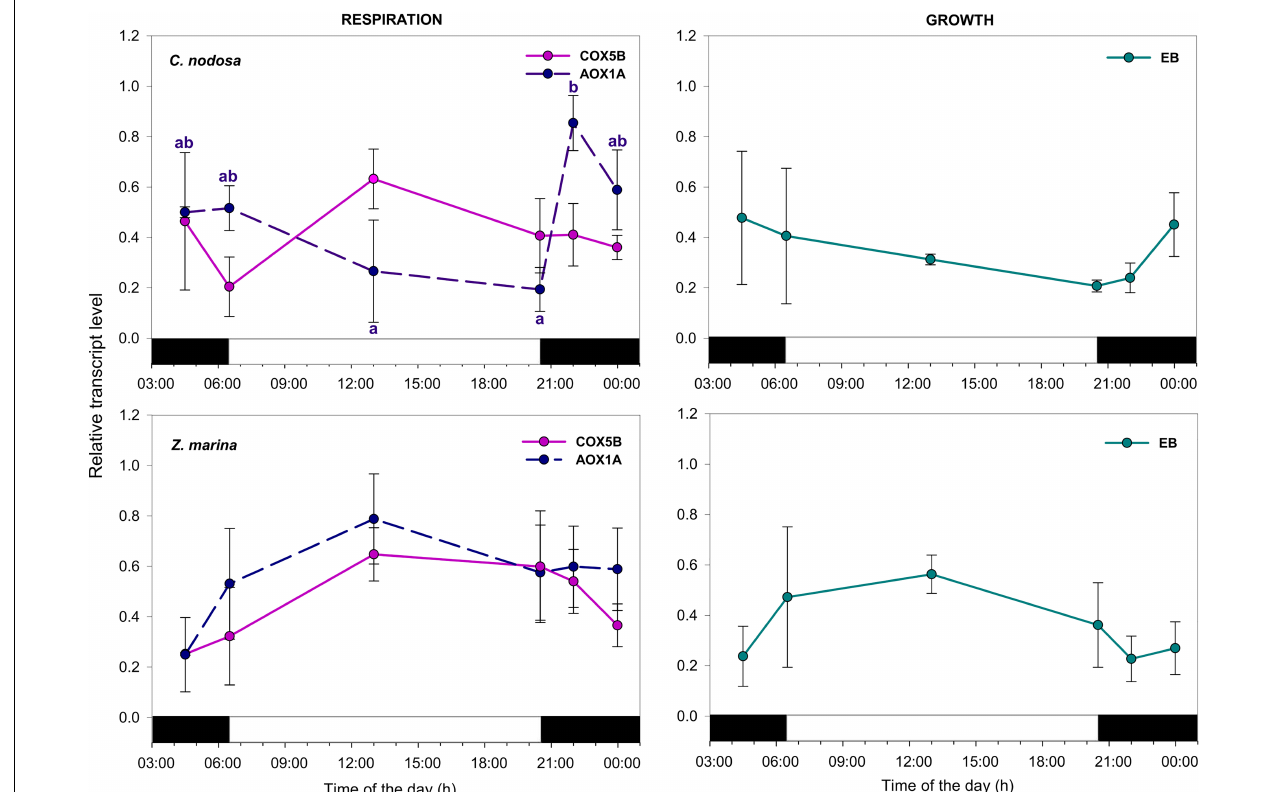
FIGURE 5 | Daily transcript levels (as normalized – (cid:49) CT data) of GOIs with a function in cellular respiration and growth in C. nodosa (upper panels) and Z. marina (lower panels). Significant daily changes ( P < 0.05) for each GOI based on SNK tests following one-way ANOVAs ( Tables 3 , 4 ), are indicated with different letters. Letters are coloured as the respective GOI. Values are mean ± SE for n =